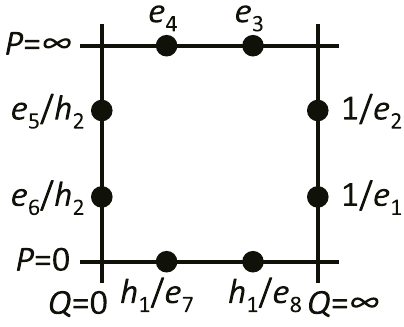
), ( 1 ; e (cid:0) 1 ), ( e 3 ; 1 ), ( e 4 ; 1 ), 1 2